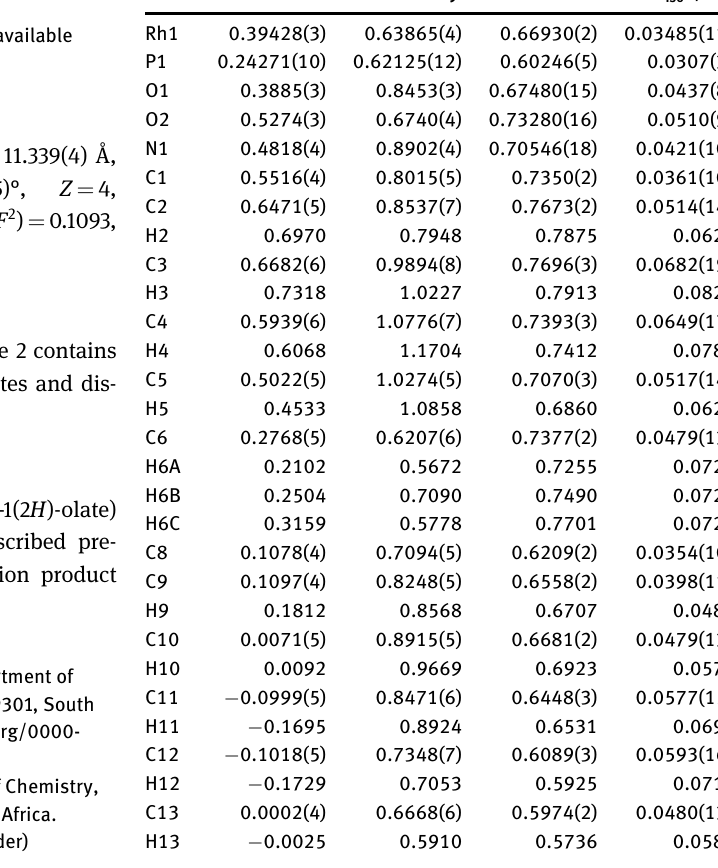
Table 2: Fractional atomic coordinates and isotropic or equivalent isotropic displacement parameters (Å 2